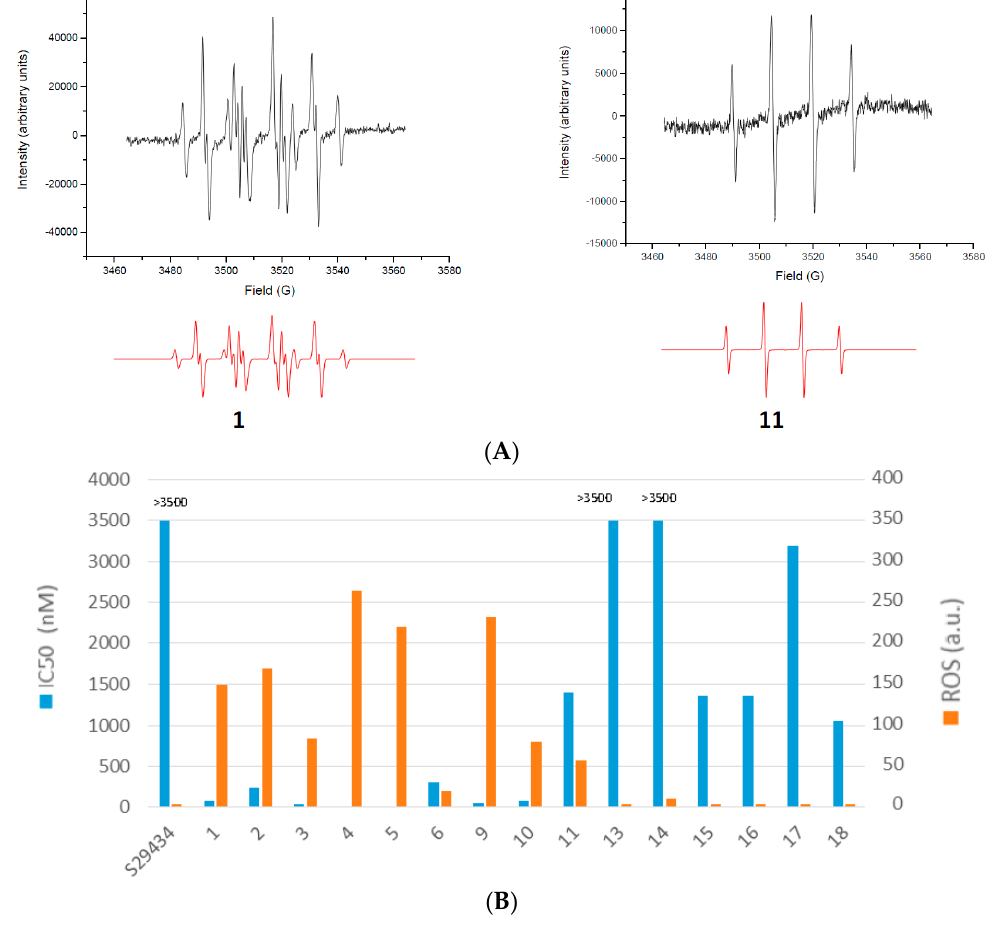
Figure 3. Free radicals produced by hQR2 metabolization of indolone derivatives. ( A ) Examples of EPR spectra recorded with the different compounds tested. Actual spectra (dark) were compared with theoretical spectra (red); ( B ) comparison of the compound potency (IC 50 in nM, blue bars P. falciparum , strain FcB1) to the amount of radicals produced in a pure hQR2 system (orange bars).